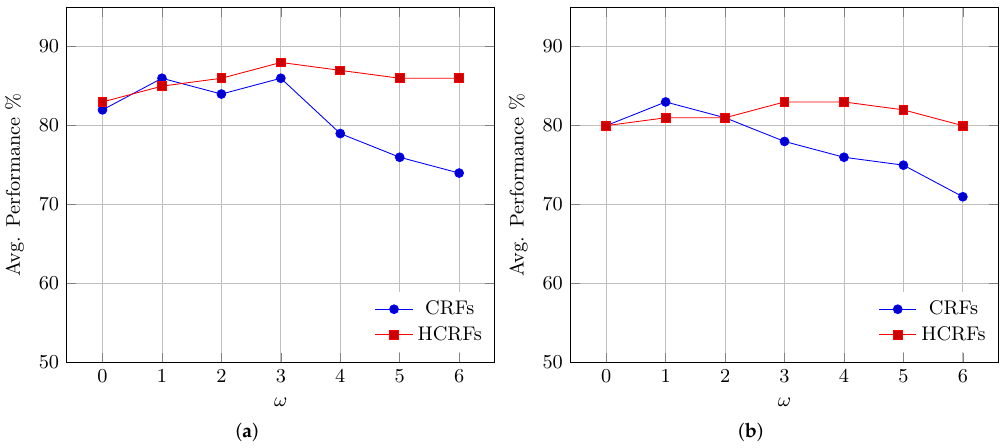
Figure 7. CRF and HCRF performance with different window sizes ( ω ): ( a ) performance on Tax.2; ( b ) performance on Tax.3.